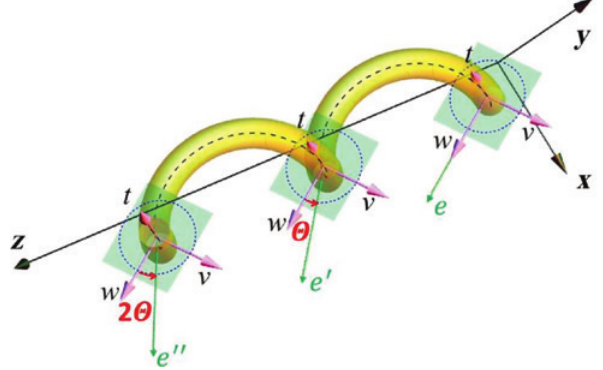
Figure 1: The polarization evolves along a twisted ray trajectory, obeying the parallel transport law. The wave polarization is meas- ured in a coordinate frame with basic vectors ( t , v , w ) accompanying the ray, where t = p / p is the tangent to the trajectory.